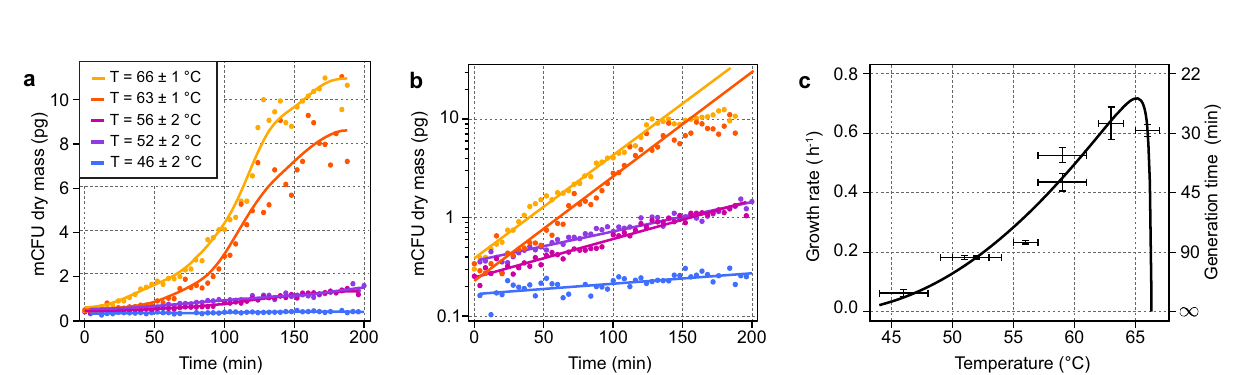
Fig. 4 | Growth rate measurements as a function of temperature. a Microbial growth at different temperatures. mCFU: microscale colony forming unit. Data acquired from a single movie of bacteria growing within a temperature gradient (movieM3). b Sameas( a )inasemi-logscale. c Growthrate τ andgenerationtime g